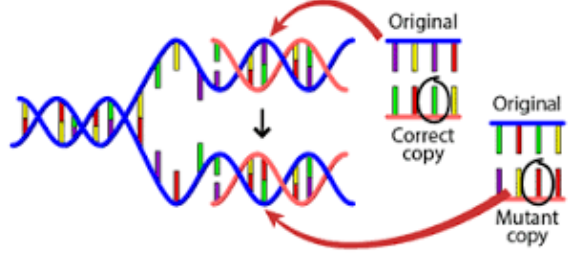
Figure 1. A point mutation in a gene.